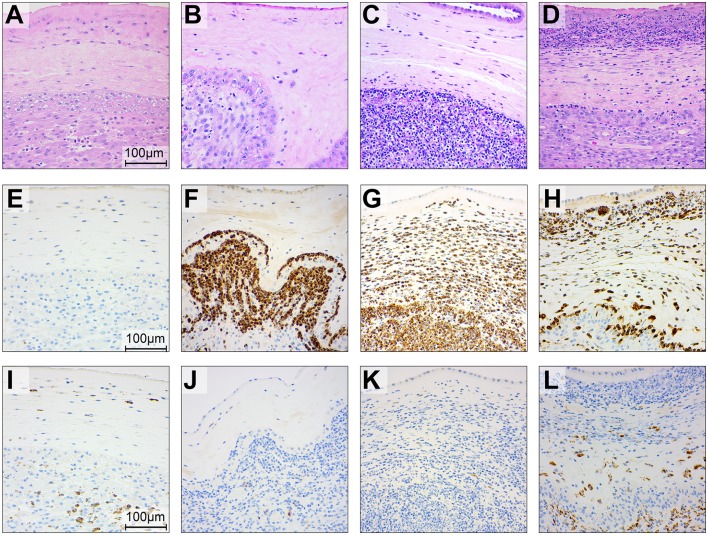
Histopathology and immunohistochemistry of the placental chorioamniotic membranes in saline controls (A,E,I), a GBS case delivered at 24 h (B,F,J) and 48 h (C,G,K) and with BSCI treatment (D,H,L). Staining for hematoxylin and eosin staining (A–D), MPO (E–H), and CD68 (I–L) was performed. In the saline control membranes, there were few macrophages and rare neutrophils (A). GBS inoculation alone was associated with recruitment of neutrophils and a profile that appeared time dependent; neutrophils were typically confined to the decidua by 24 h after GBS inoculation (B) and then spread to the chorion and amnion by 48 h (C). Pre-treatment with the BSCI and GBS inoculation was associated with similar features to GBS cases delivered at 48 h, but a greater dispersion of neutrophils throughout the entire chorioamniotic membranes (D, 72 h after GBS inoculation). Immunostaining for MPO and CD68 demonstrated a subjective increase in MPO+ (H) and CD68+ cells (L) in the BSCI treated vs. GBS alone (F,G,J,K) and saline (E,I) groups.